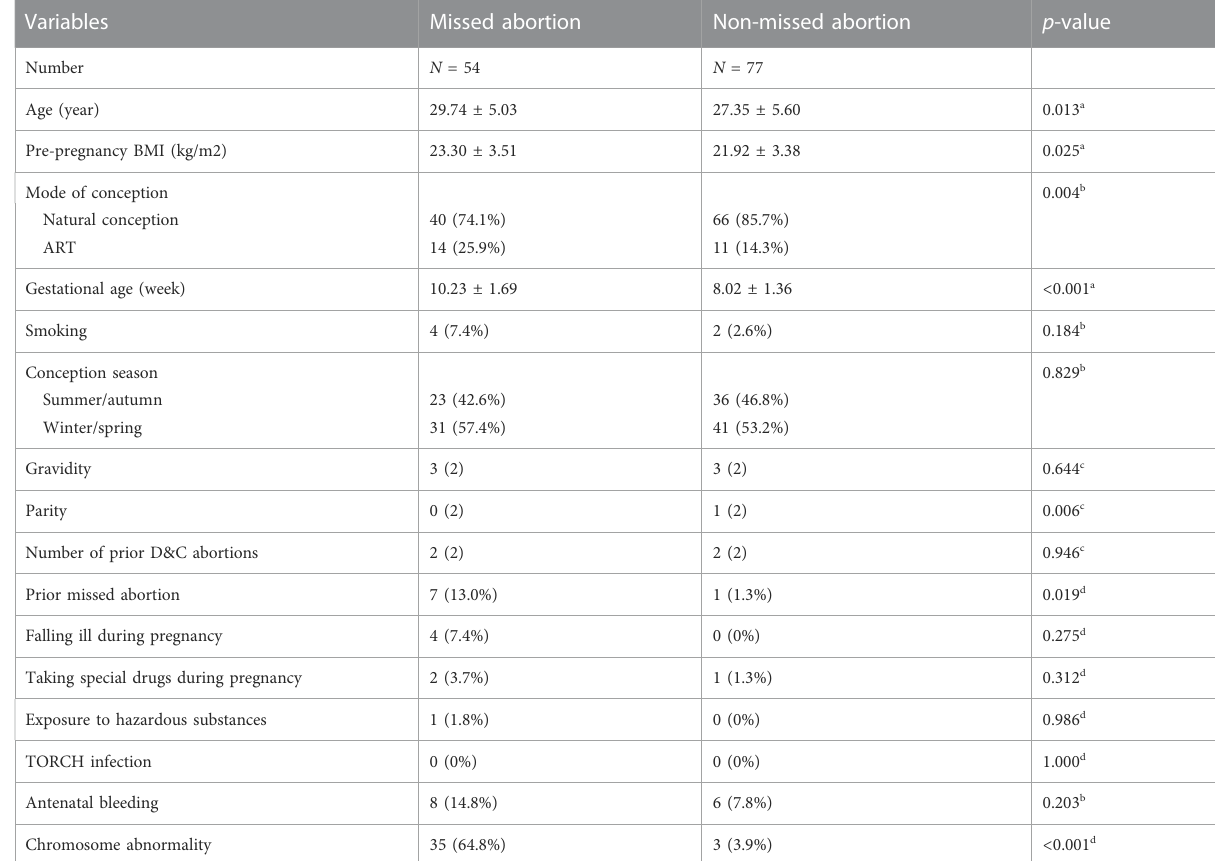
TABLE 2 Description of the abortion women ’ s characteristics by type of abortions.